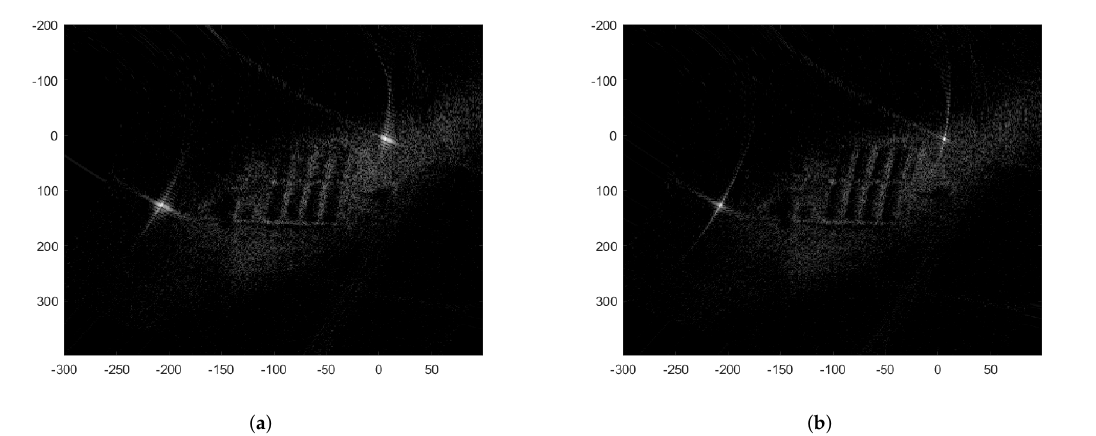
Figure 14. Images results of Baotou; ( a ) BFSAR image processed by the algorithm proposed in [41]; ( b ) BFSAR image processed by the proposed